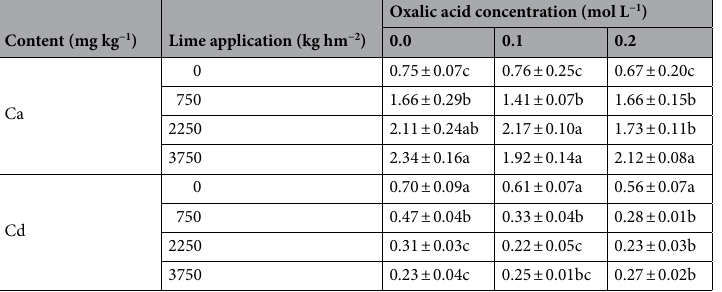
Table 2. Effects of foliar spraying of oxalic acid on contents of Cd and Ca in roots of Panax notoginseng under Cd stress. Date were means ± SD. Different lowercase letters in the same column indicate significant differences at the level of P <